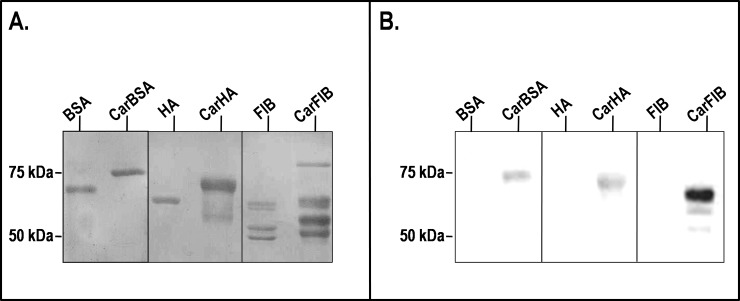
Electrophoretic mobility of carbamylated serum proteins and their immunoreactivity with anti-CarP Ab.(A) Native and carbamylated proteins (2 μg per lane) were analyzed by 10% SDS-PAGE under reducing conditions and stained with Coomassie brilliant blue. Molecular weight markers were run on a parallel track. (B) Native and carbamylated proteins (500 ng/lane) were separated by 10% SDS-PAGE under reducing conditions, transferred to a PVDF filter, and incubated overnight with affinity-purified anti-CarP Ab. Bound Ab were detected using HRP-conjugated goat anti-human IgG and ECL substrate. BSA, bovine serum albumin; HA, human albumin; FIB, fibrinogen; Car, carbamylated.